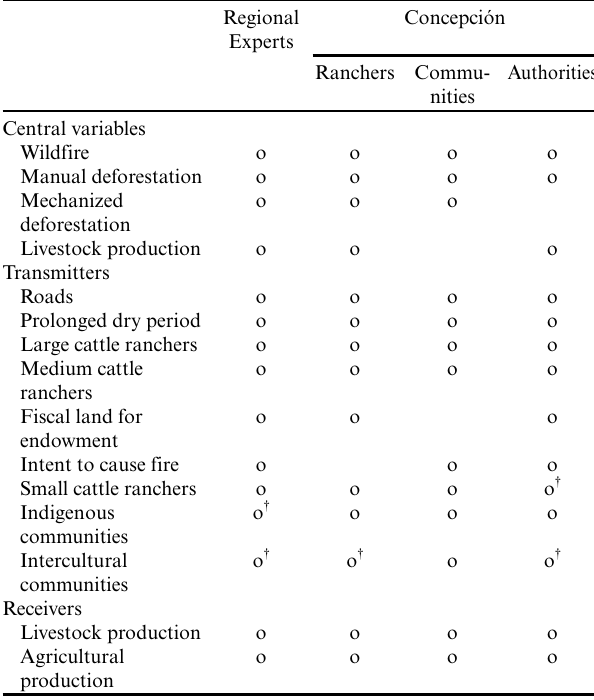
Table 3 . Common key variables in the regional (1) and local (3) fuzzy cognitive maps (FCM) of the wildfire system in the